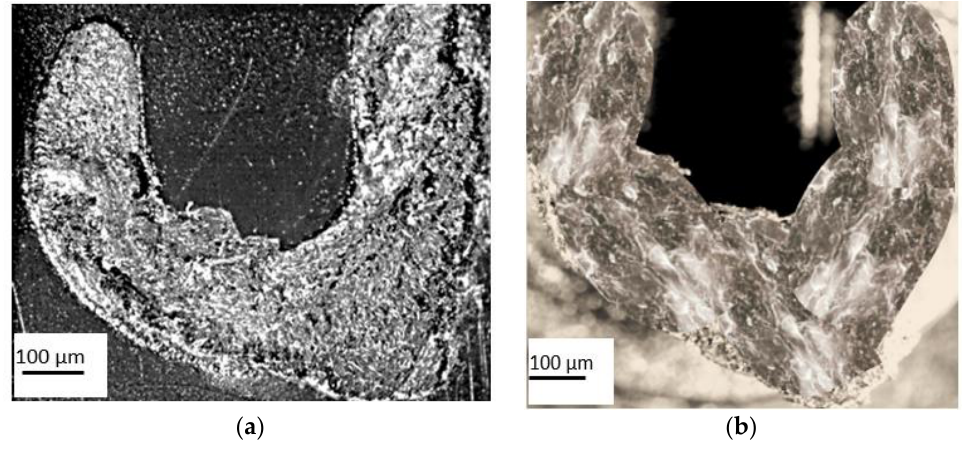
Figure 8. Macroscopic images of the part’s breaking area. ( a ) — new parts; ( b ) — parts subject to the process of artificial aging.